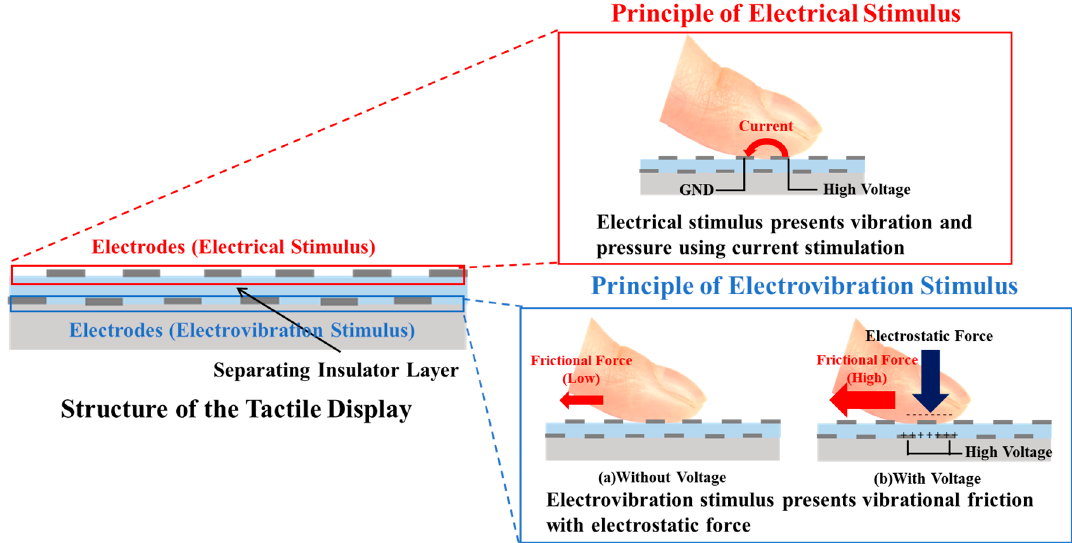
Figure 2. Principle and structure of the proposed tactile display. Electrodes for electrical stimulus are located on the surface of the tactile display. The electrodes for the electrovibration stimulus were formed under the electrodes for the electrical stimulus.